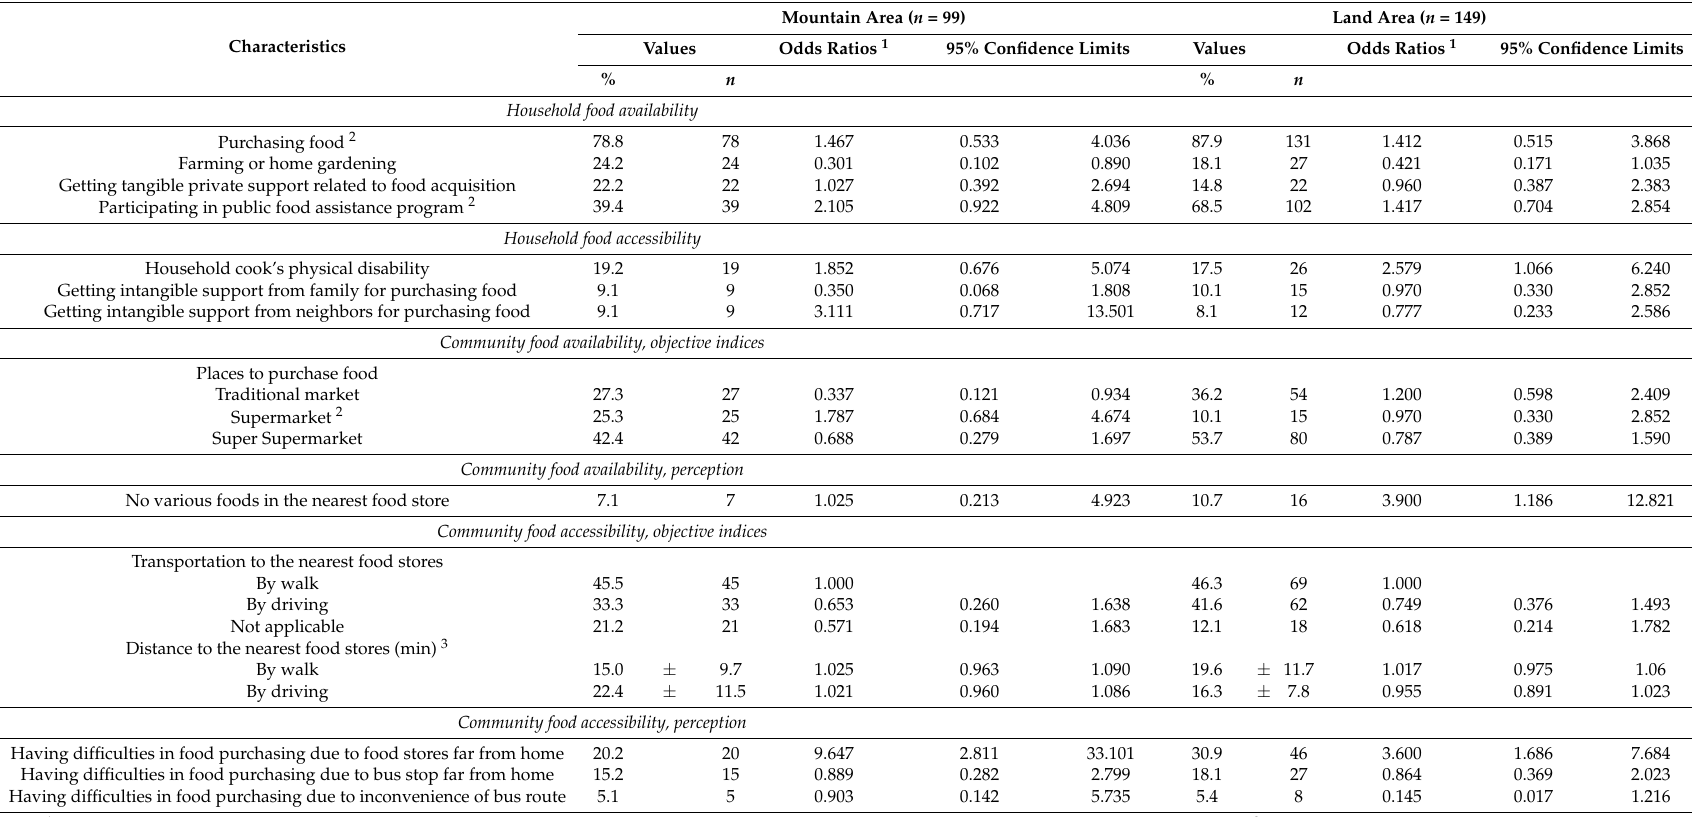
Table 3. Food environmental characteristics of households and risks for food insecurities according to rural